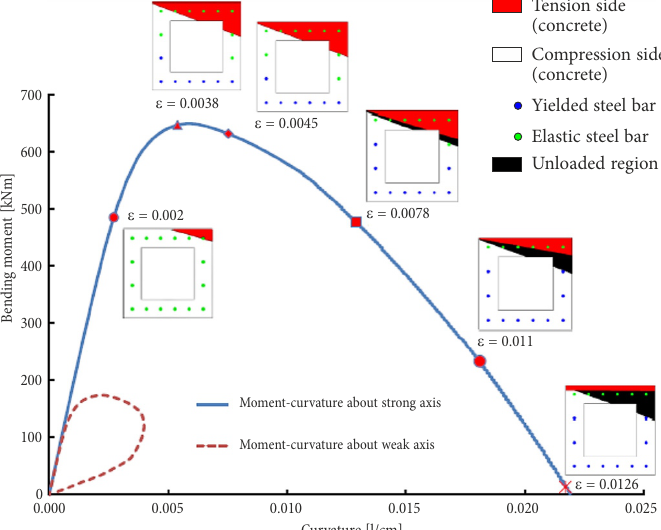
Fig. 17. Moment curvature diagrams for different values of degree of confinement and compressive axial force of N = 6000 kN and a = 26.56 ° : Bending moment about Y -axis(weak axis)